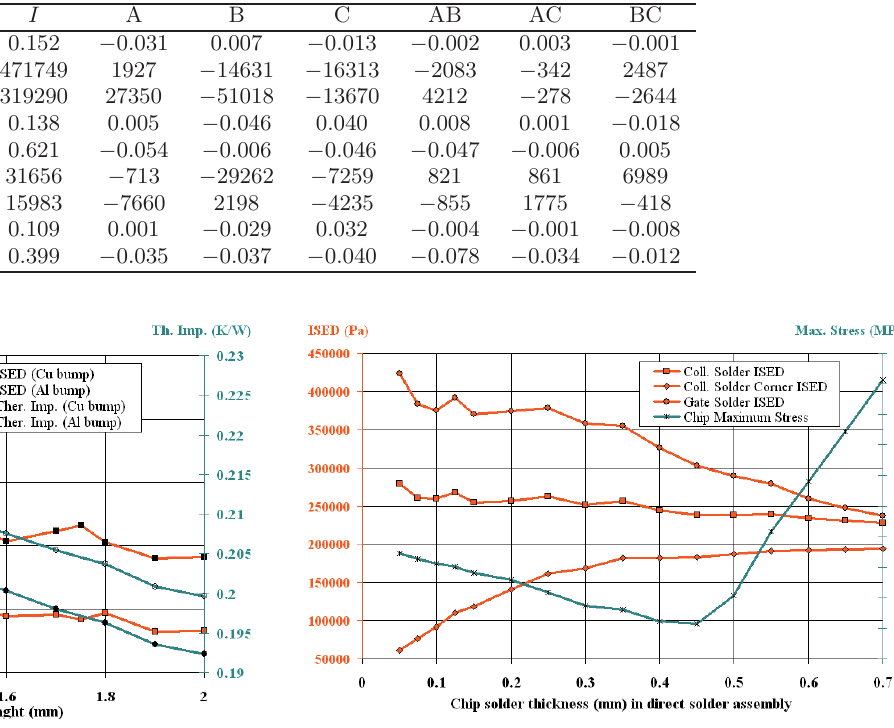
Fig. 23. Evolution of direct connection solders ISED and chip maximal principal stress with chip solder joint